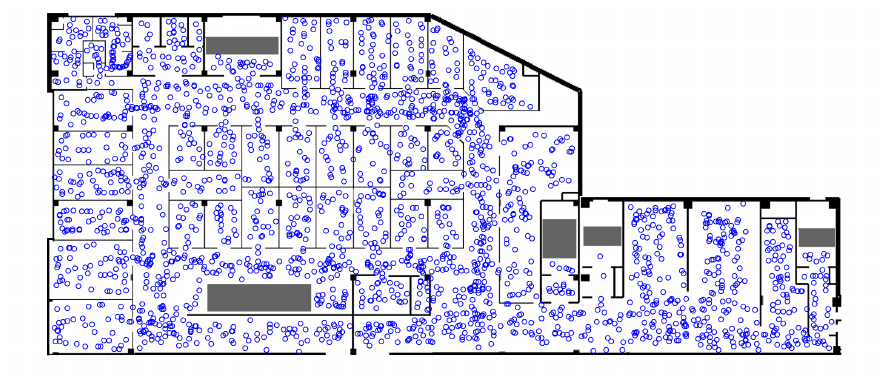
Figure 5. The experimental scene at a mall along with the points where fingerprints were